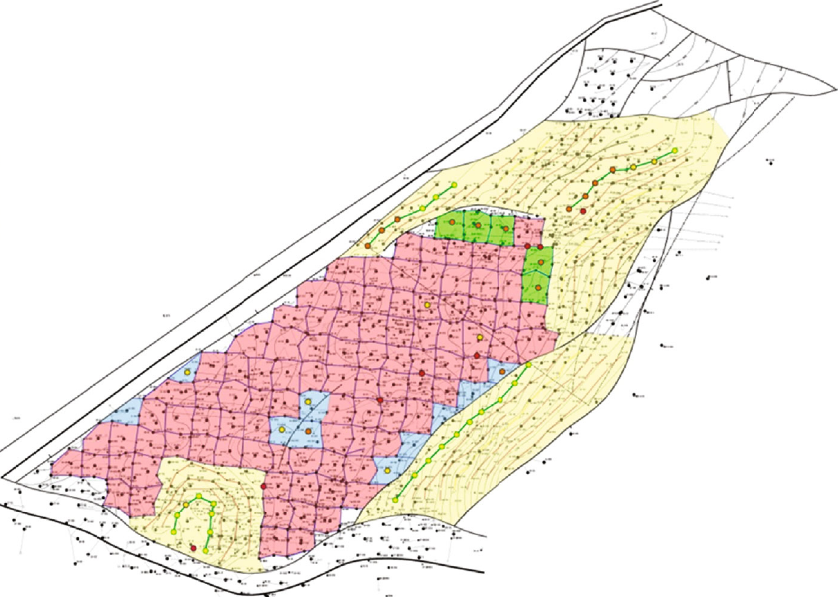
Figure 1: Inverted nine-spot well patterns of D block in Liaohe Oil fi eld, with red colour showing the area for ISC implementation and yellow colour showing the area for CSS